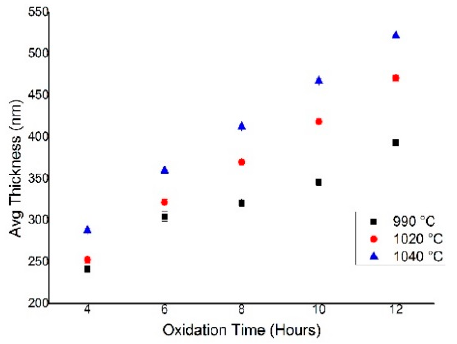
Figure 5. Oxide thickness against oxidation time of thermal dry oxidation for silicon <100>.